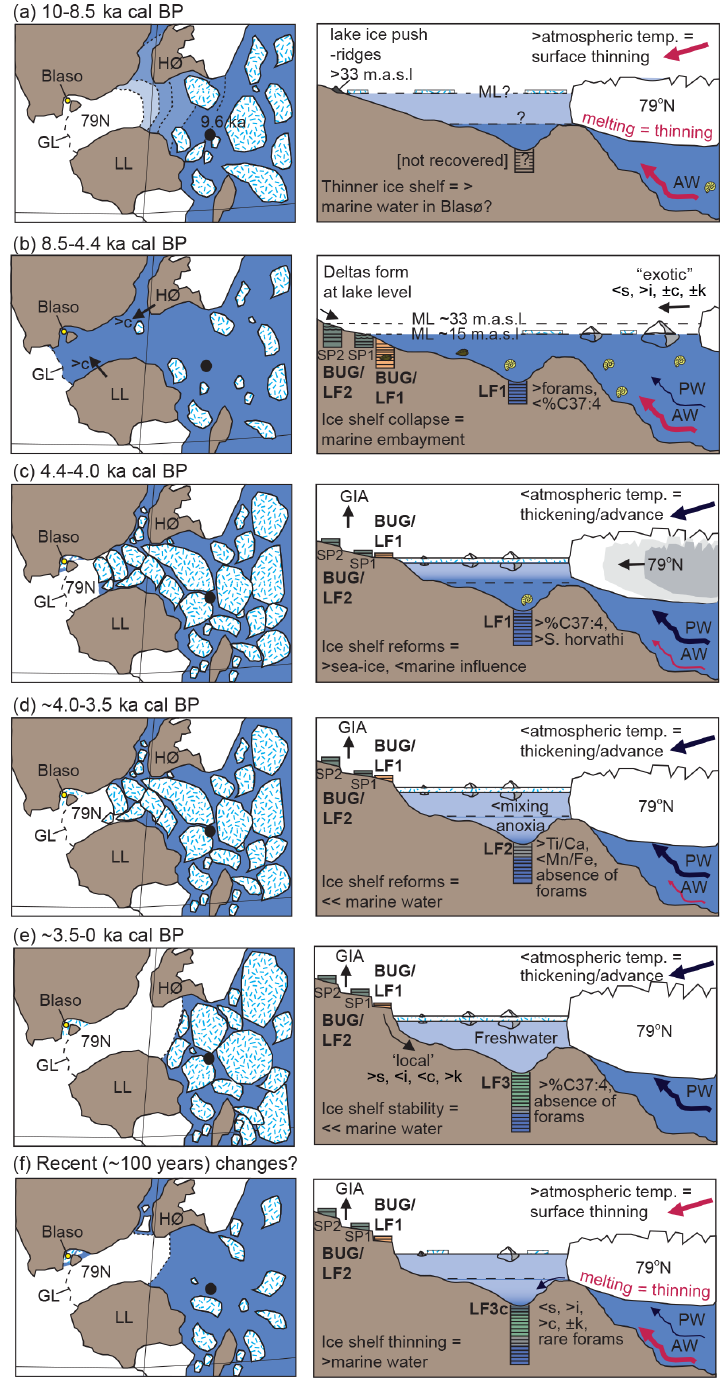
Figure 11. Reconstruction of the 79 ◦ N ice shelf from 10kacalBP to present, showing the location of Blåsø, Lambert Land (LL), and Hovgaard Ø (HØ). Constraints on sea-ice (blue-hatched polygons) formation and ocean circulation on the adjacent continental shelf (left column) are derived from core PS100/270 (closed black circle; Syring et al., 2020). Relative proportions of Atlantic Water (AW) and Polar Water (PW) are shown as thick/thin arrows. Conditions in Blåsø catchment (right column) prior to 8.5kacalBP (youngest shell age) are inferred. Relative proportions ( > denotes high, < denotes low, and ± denotes variable) of the inferred pathways of smectite (s), illite (i), chlorite (c), and kaolinite (k) are indicated as well as the key attributes of lithofacies (LF) 1–3 in lake cores and Blåsø uplifted (BUG) lithofacies. Paler blue shading indicates more brackish/fresh water in Blåsø. ML stands for marine limit and GIA represents glacial isostatic adjustment. The yellow circle in Blåsø (left column) shows the relative positions of cores LC7 and LC12.